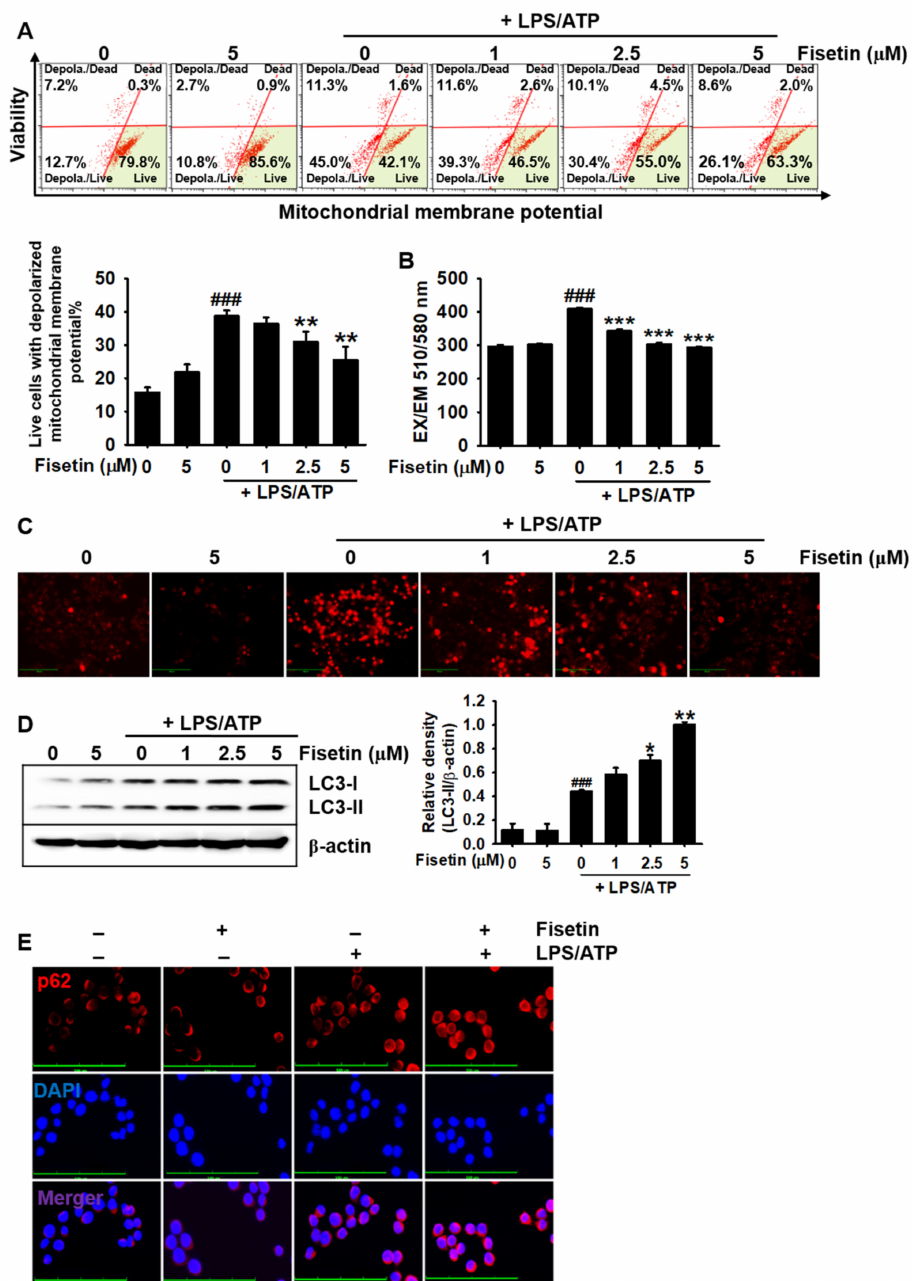
Figure 5. Fisetin inhibits mitochondrial membrane depolarization and promotes mitophagy. BV2 microglial cells were treated with the indicated concentrations of fisetin (0–5 µ M) for 2 h and subsequently stimulated with 1 µ g/mL LPS for 2 h, followed by stimulation with 1 mM ATP (LPS/ATP) for an additional 2 h. ( A ) Populations of depolarized mitochondria were measured using a Muse MitoPotential Kit. ( B , C ) Cells were stained with 2 µ M MitoSOX Red for 10 min and ( B ) fluorescence intensities were measured using fluorometry. ( C ) Images of cells were captured using a CELENA S Digital Imaging System. ( D ) In a parallel experiment, total proteins were extracted after 9 h of treatment with LPS/ATP. Western blotting was performed for detecting the expression of LC3. β -Actin was used as a loading control. ( E ) Cells were fixed with 4% paraformaldehyde and immunostained for p62 with Alexa Fluor 647-conjugated secondary antibody. The results indicate the mean ± standard error median (SEM), and is representative of the results obtained from three independent experiments. Images were captured using a CELENA S Digital Imaging System. ### p < 0.001 vs. untreated cells; *** p < 0.001, ** p < 0.01 and * p < 0.05 vs. LPS/ATP-treated